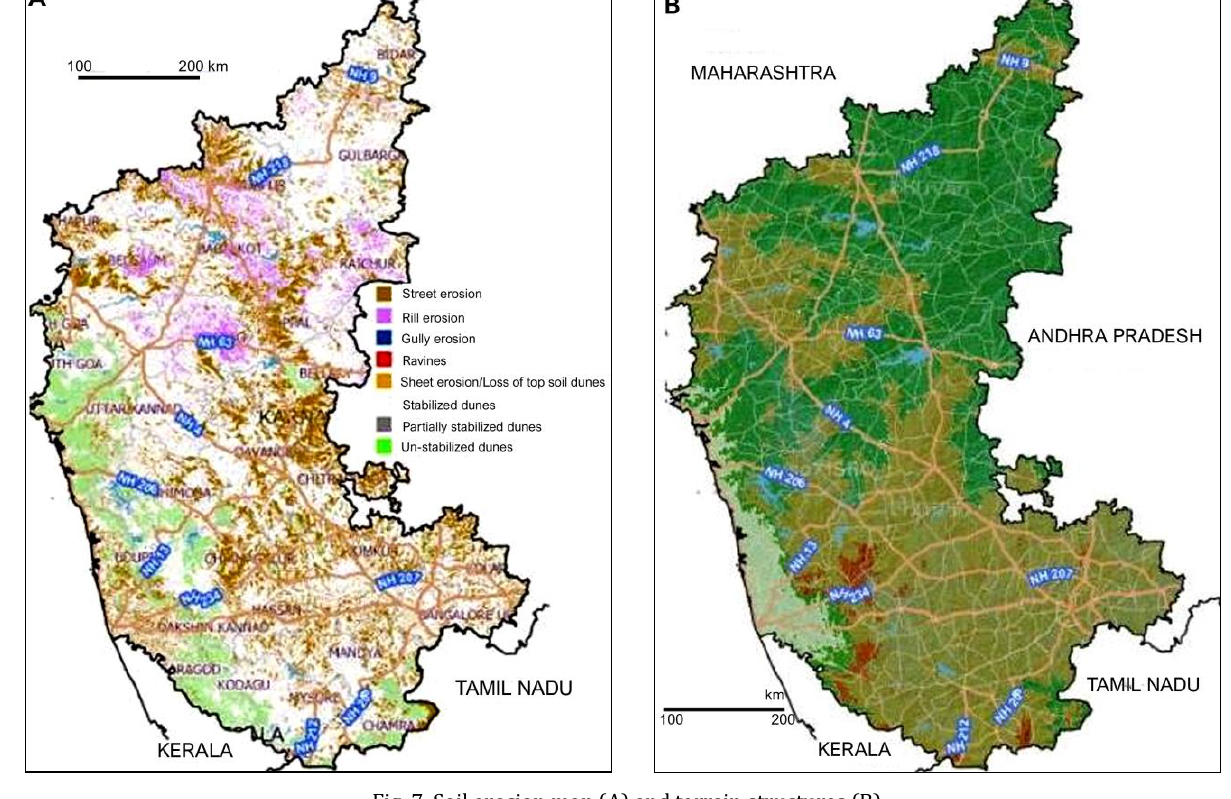
Fig. 7. Soil erosion map (A) and terrain structures (B)